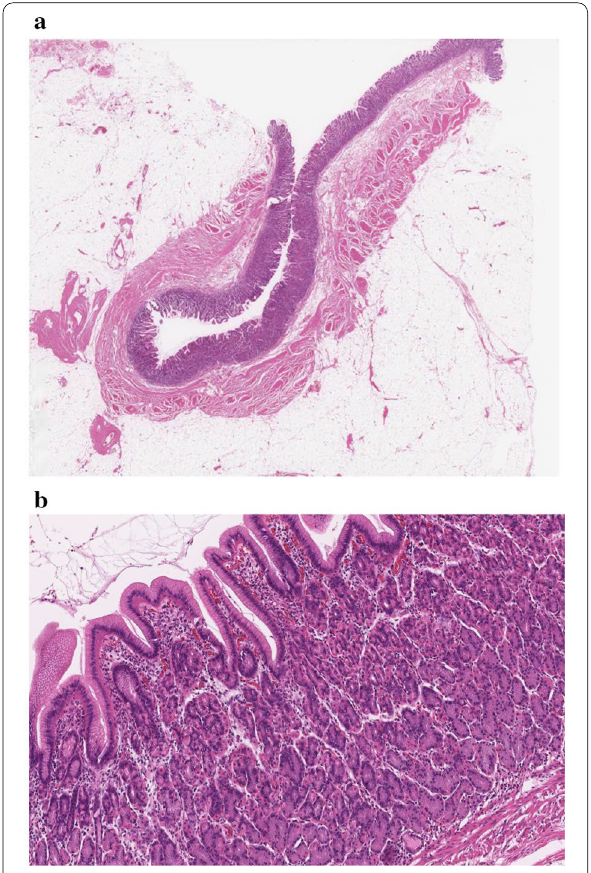
Fig. 5 Pathological findings. a True diverticulum with a muscular layer is evident. b Presence of ectopic gastric mucosa is confirmed